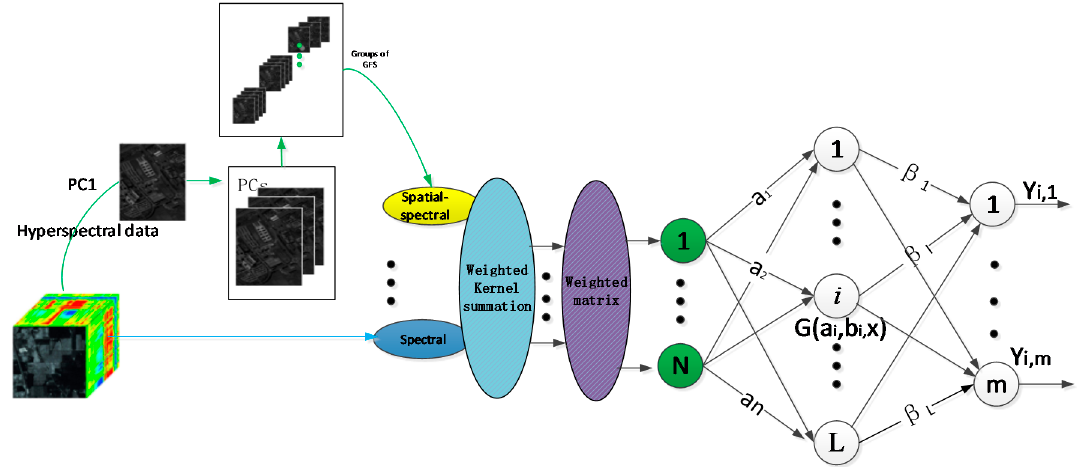
Figure 1. Flowchart of the proposed dual-weight kernel extreme learning method.